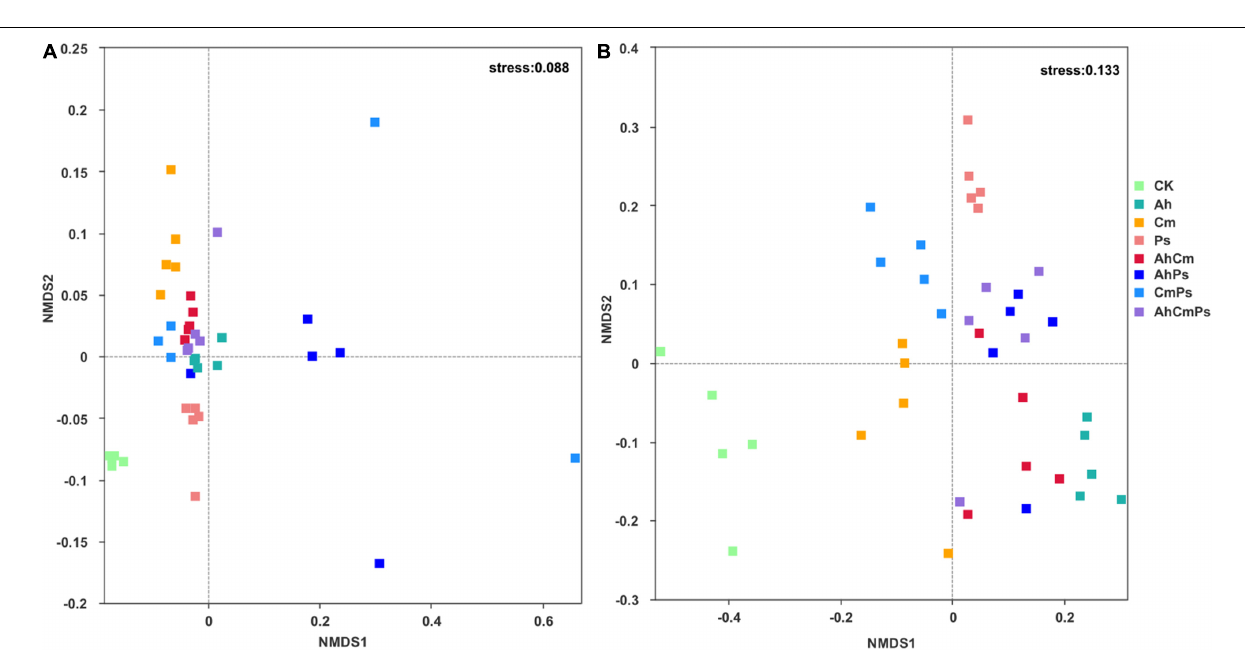
Frontiers in Microbiology |